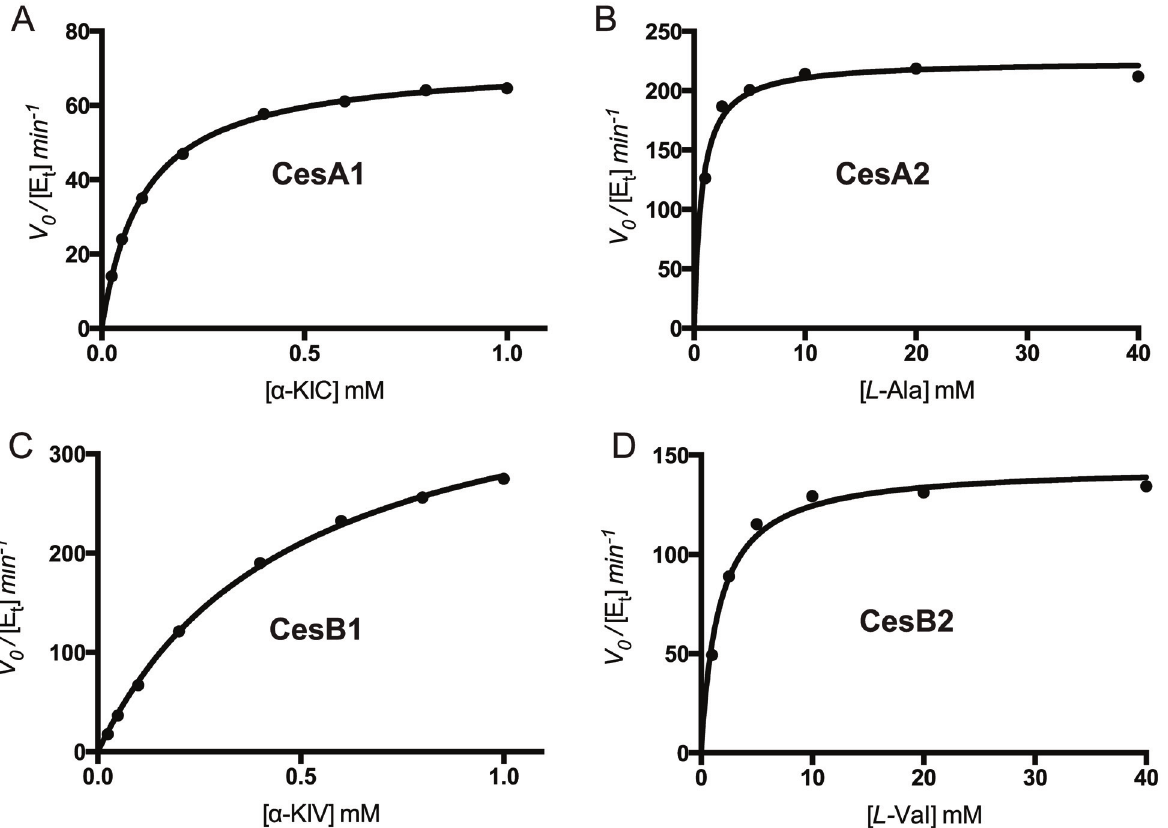
Fig 2. Kinetic characterization of adenylation by A domains using the ATP-PPi exchange assay. Initial velocity versus substrate concentration plots for adenylation of cognate substrates for CesA1 (A), CesA2 (B), CesB1 (C) and CesB2 (D). Curves were fit to the Michaelis-Menten equation. The kinetic parameters obtained are listed in Table